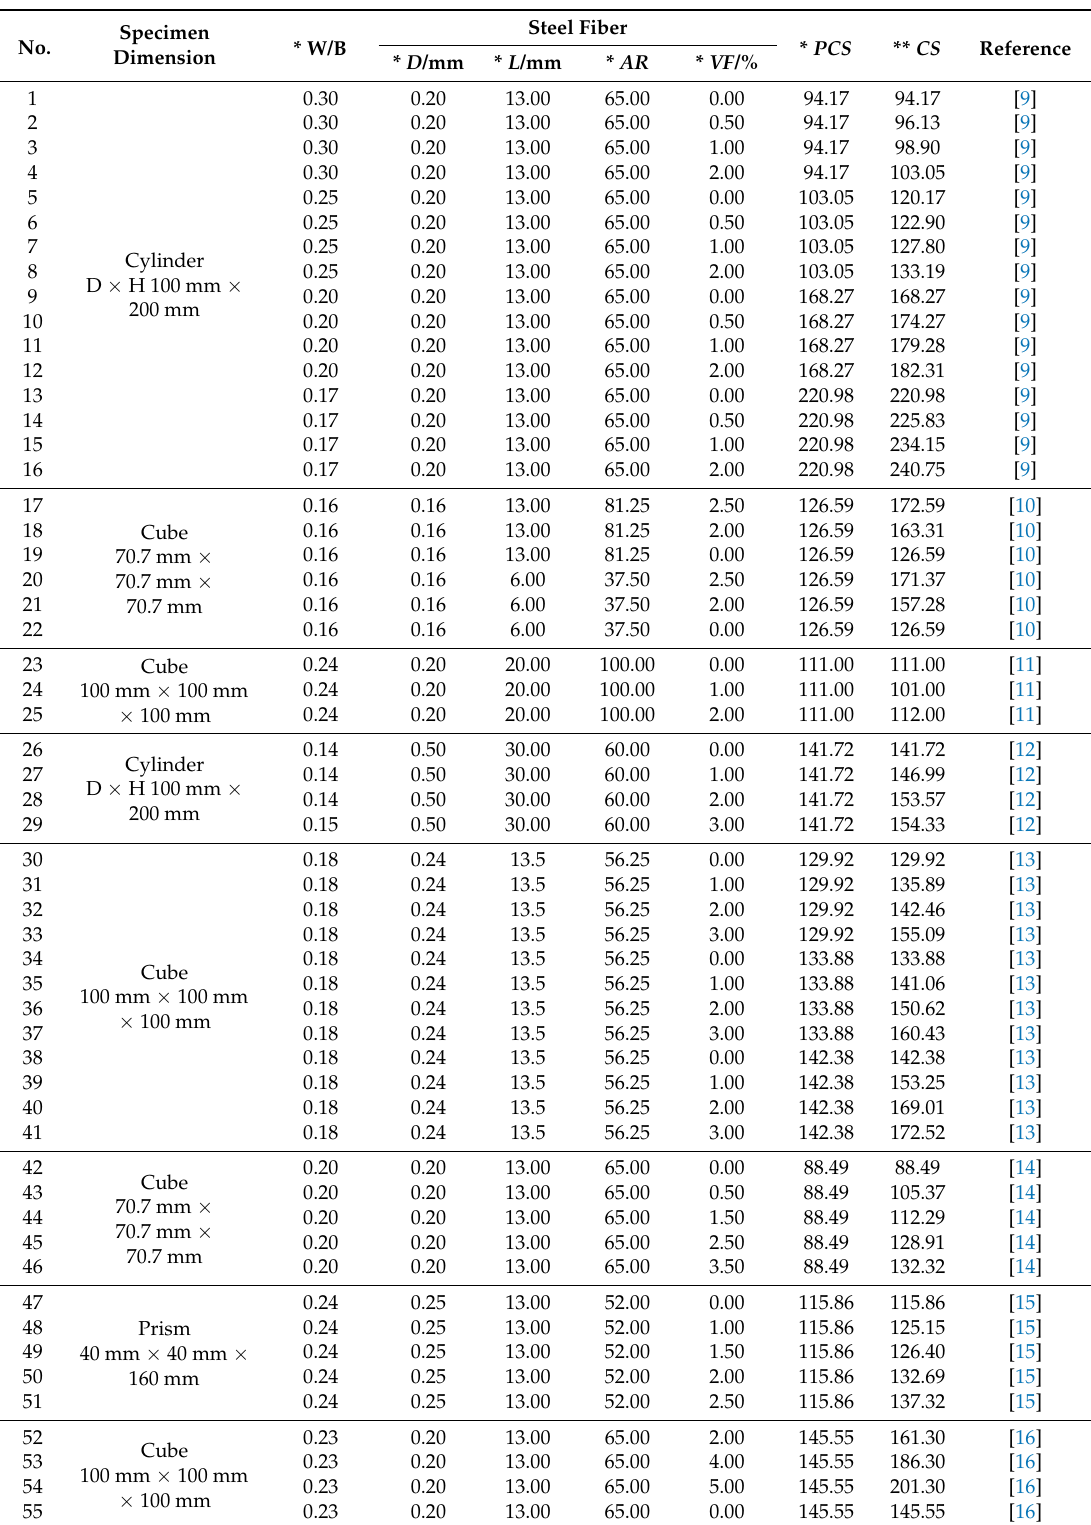
Table 1. Experimental Data used for establishing Compressive Strength Artificial neyral network (ANN)